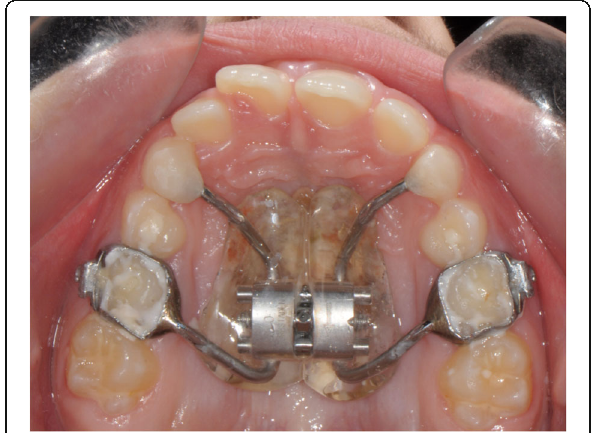
Fig. 1 Haas-type expander on deciduous second